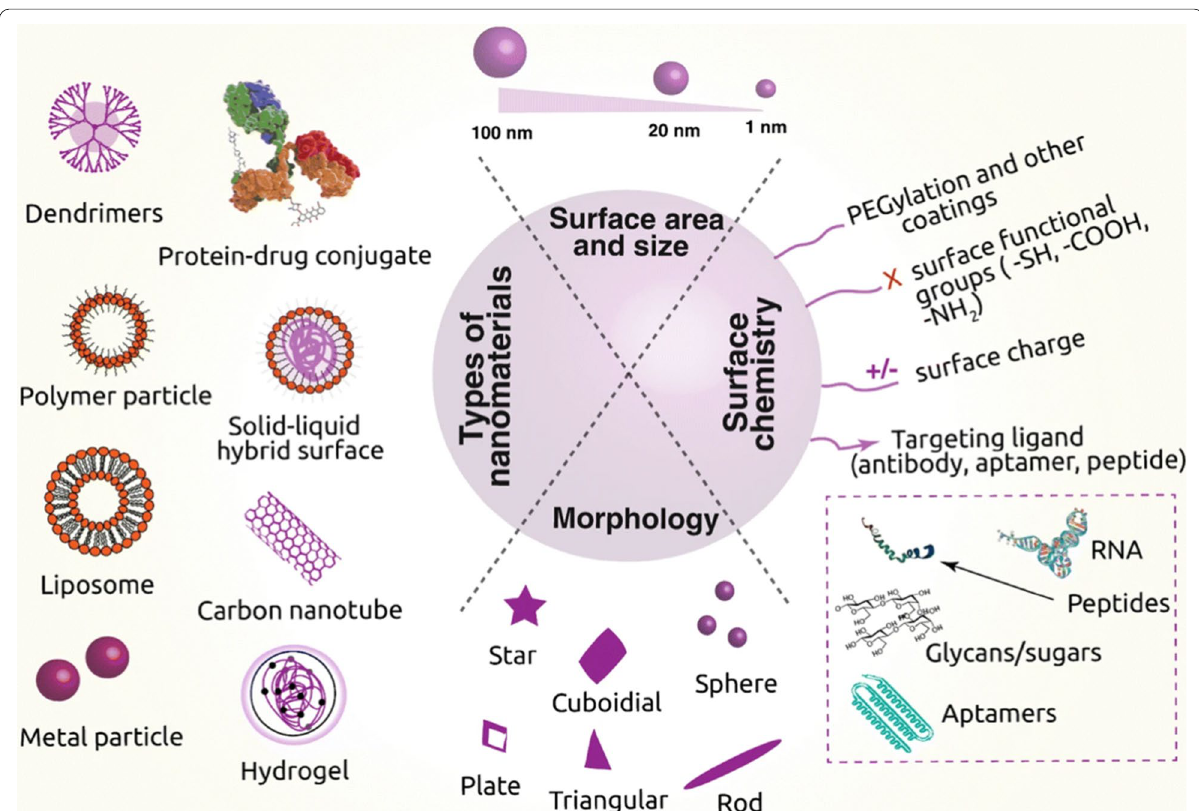
Fig. 3 Schematic representation of versatile nanoformulations employed in cancer therapy and diagnostics, including specific physical formulation and surface chemistry for improved targeting. Reprinted with permission, [71] https:// doi. org/ 10. 1186/ s40580- 019-